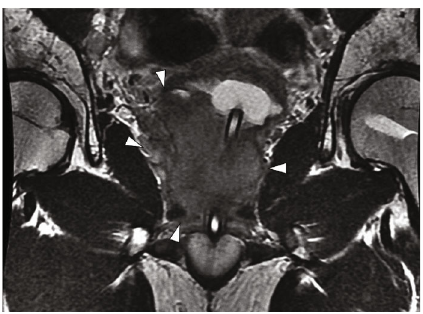
Figure 1: The irregular enlarged prostate with urinary bladder invasion (arrows).